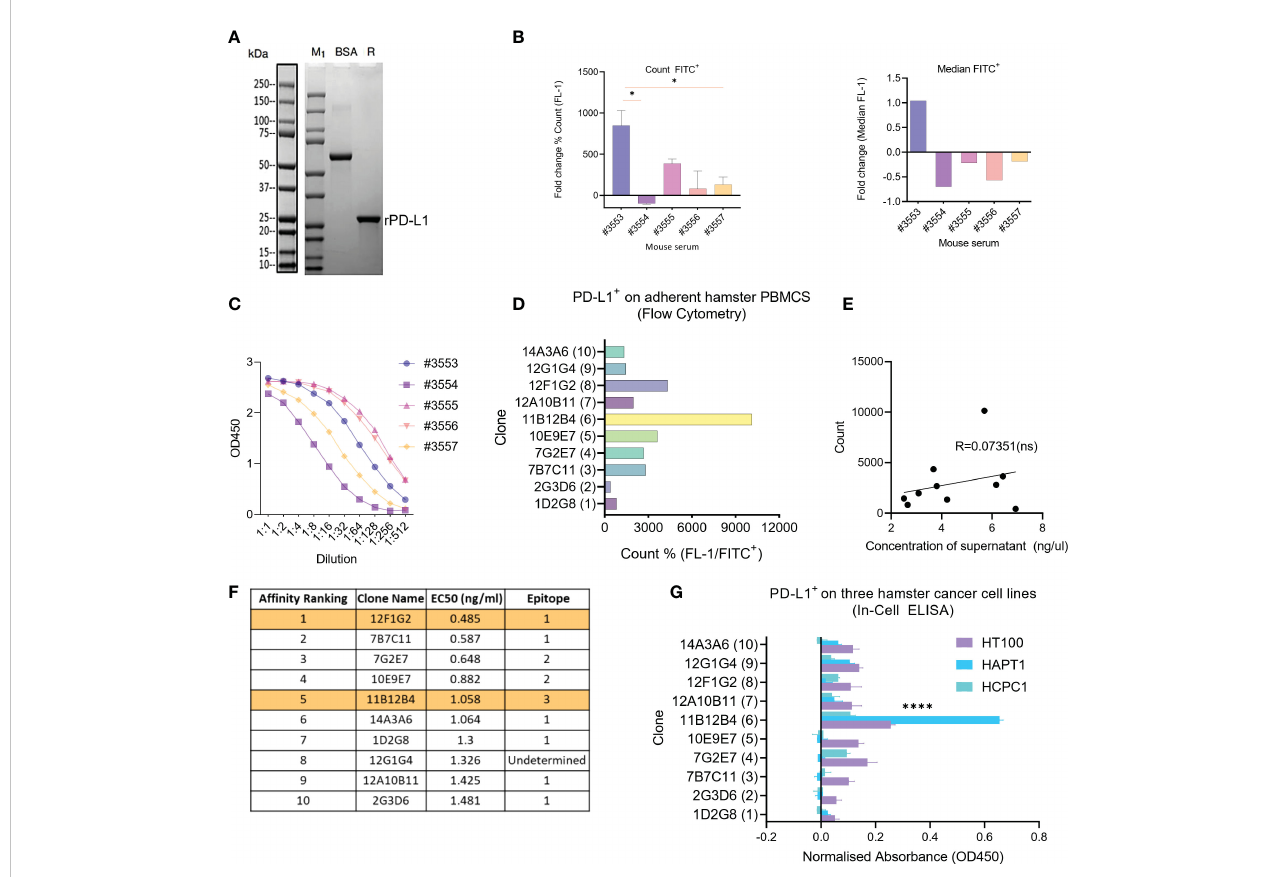
FIGURE 1 Generation of anti-Syrian hamster PD-L1 clones and their characterization for subcloning. (A) Con fi rmation of recombinant Syrian hamster PD-L1 expressed in E.coli by SDS-PAGE where M 1 indicates protein ladder, BSA (2.00 µg) positive control and R: reducing conditions. Puri fi ed recombinant PD- L1 is indicated by the arrow under reducing conditions (~20-25kDa). (B) Detection of PD-L1 on HaPT1 cell line using antiserum of fi ve mice immunized with recombinant PD-L1 by fl ow cytometry with count, mean and median (FITC + ) shown on the left and right respectively. (C) ELISA results of antiserum from give mice after 3 rd immunization against recombinant PD-L1. (D) Detection of endogenous PD-L1 on adherent Syrian hamster PBMCs using anti- PD-L1 subclones from hybridoma supernatants (1:100) by fl ow cytometry. (E) Pearson ’ s correlation indicating a non-signi fi cant relationship between measured concentrations of hybdridoma supernatant and count used in Figure (D) . (F) Af fi nity ranking and epitope binning of anti-PD-L1 subclones as measured by competitive ELISA using recombinant PD-L1. The fi nal two selected clones are highlighted in orange. (G) Detection of endogenous PD-L1 on three Syrian hamster cancer cell lines HT100, HapT1 and HCPC-1 using In-Cell ELISA. The absorbance values were normalized to cell number as measured by Janus Green Whole-Cell Stain. Data and error bars are presented as mean ± SEM. Statistical signi fi cance was determined by one-way ANOVA. *p < 0.05, ****p <